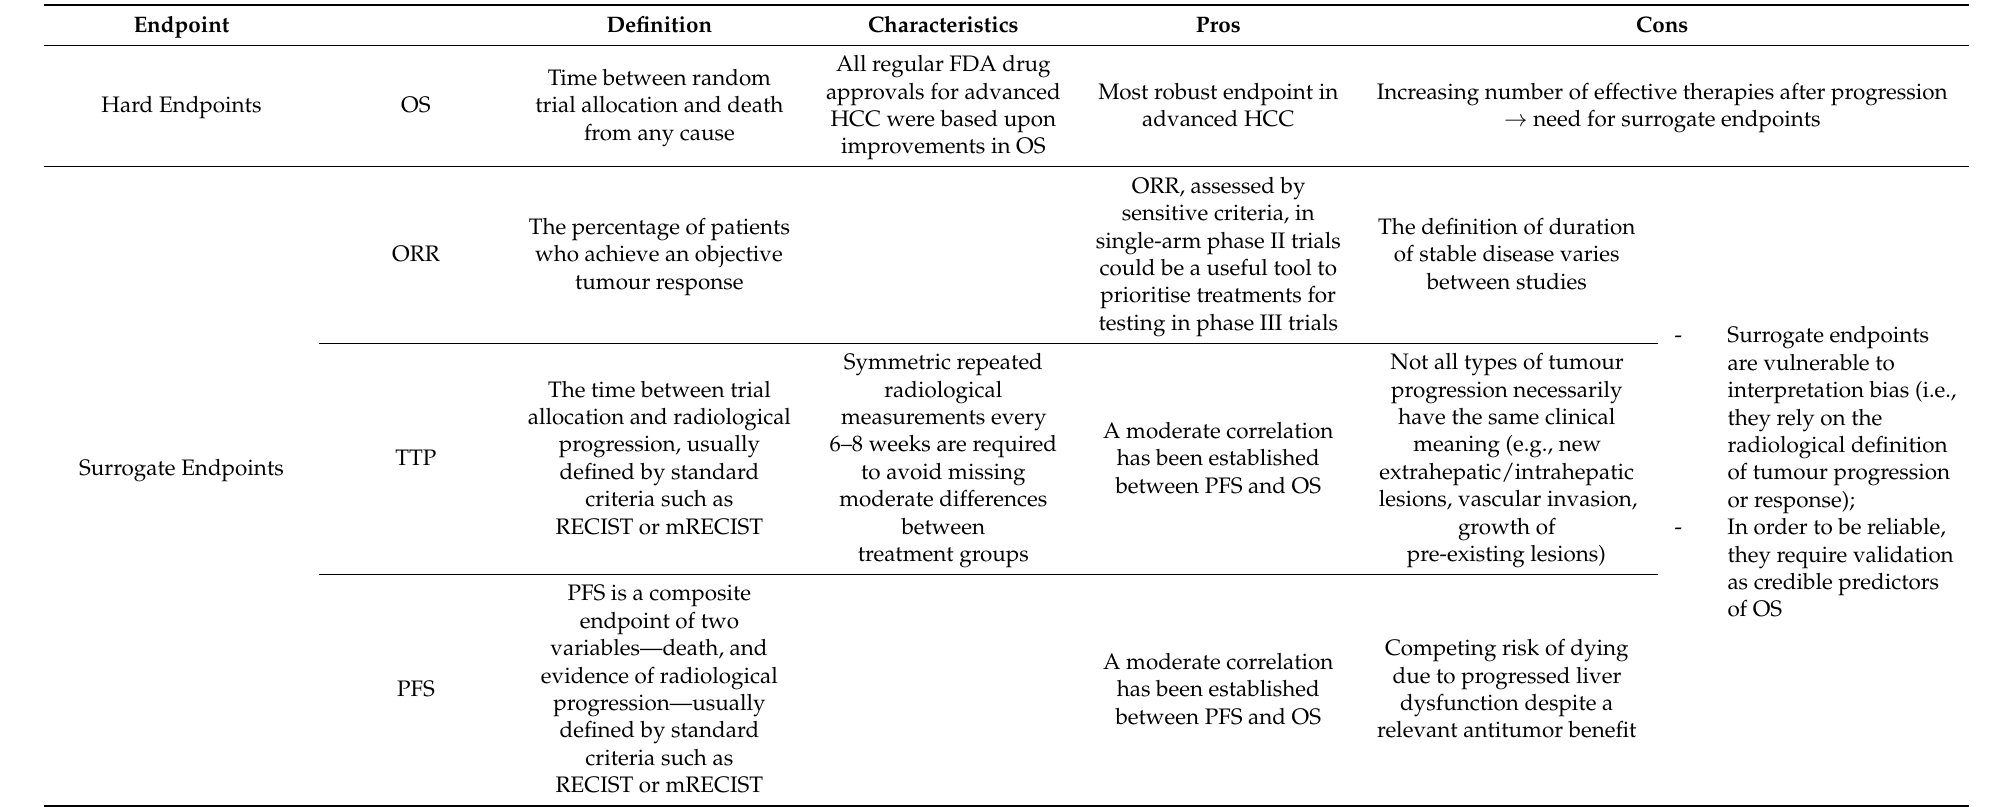
Table 1. Endpoints in oncology